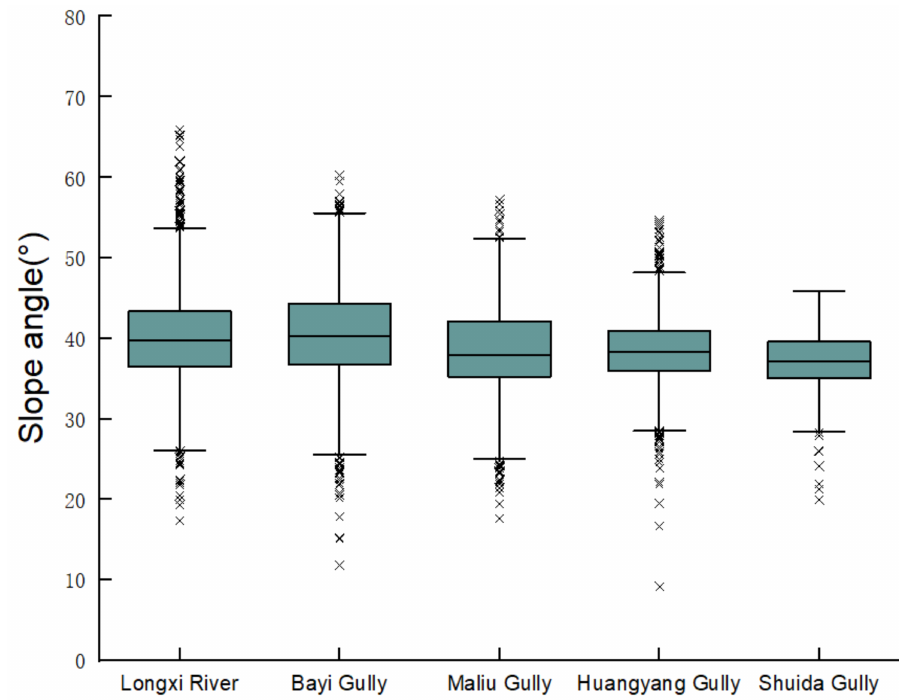
Figure 13. Distribution map of landslide slope